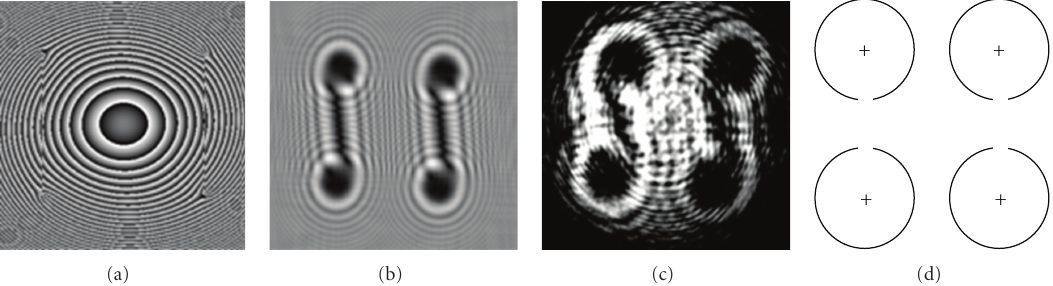
Figure 7: Fresnel lens with 2 × 2 lattice of fractional vortices of the same charge m = 3 . 5 embedded at o ff -axis locations. (a) Phase distribution displayed on SLM. (b) Simulated intensity pattern near the focal plane. (c) Experimentally observed intensity distribution near the focal plane. (d) Distribution of topological charge in the intensity pattern.